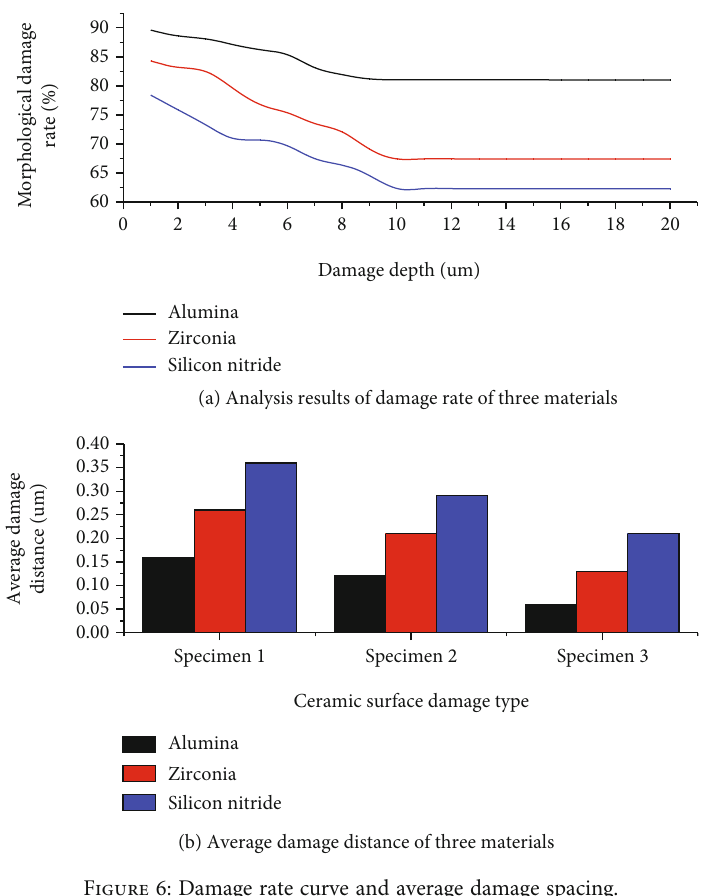
Figure 6: Damage rate curve and average damage spacing.